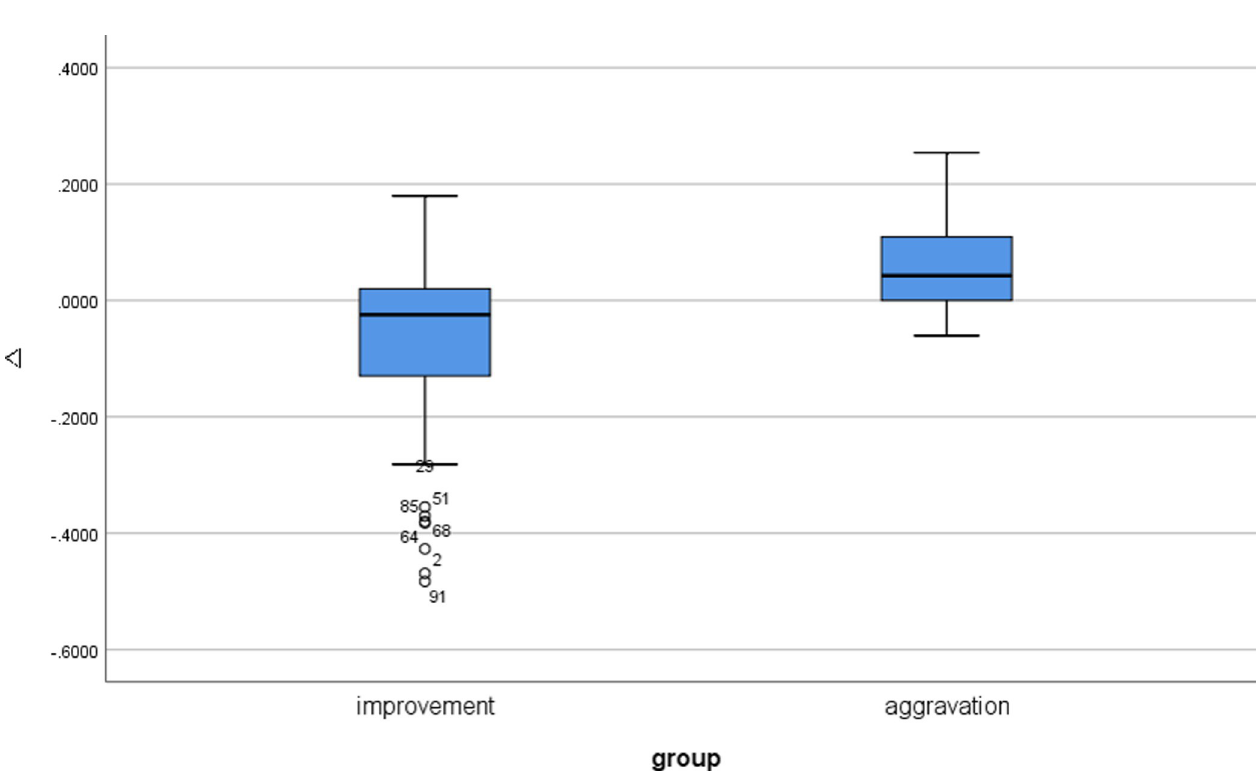
Fig 6. Box plot of probability score changes on follow-up images on pneumonia test dataset (n = 100).